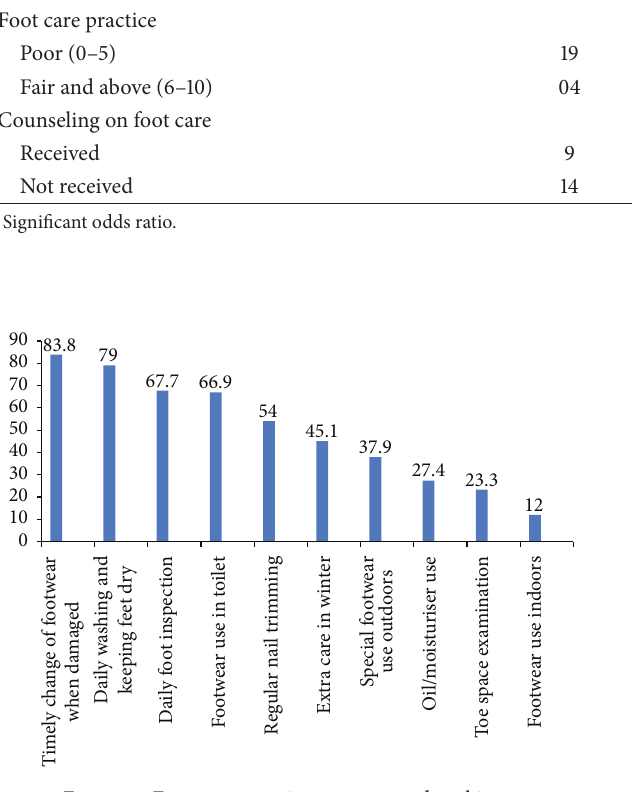
Figure 1: Foot care practices among study